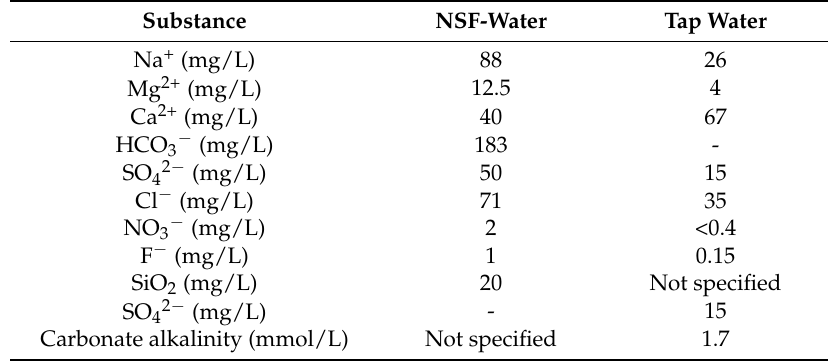
Table 1. Composition of NSF water and a tap water from northern